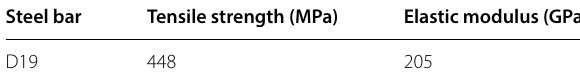
Table 3 Material properties of steel.